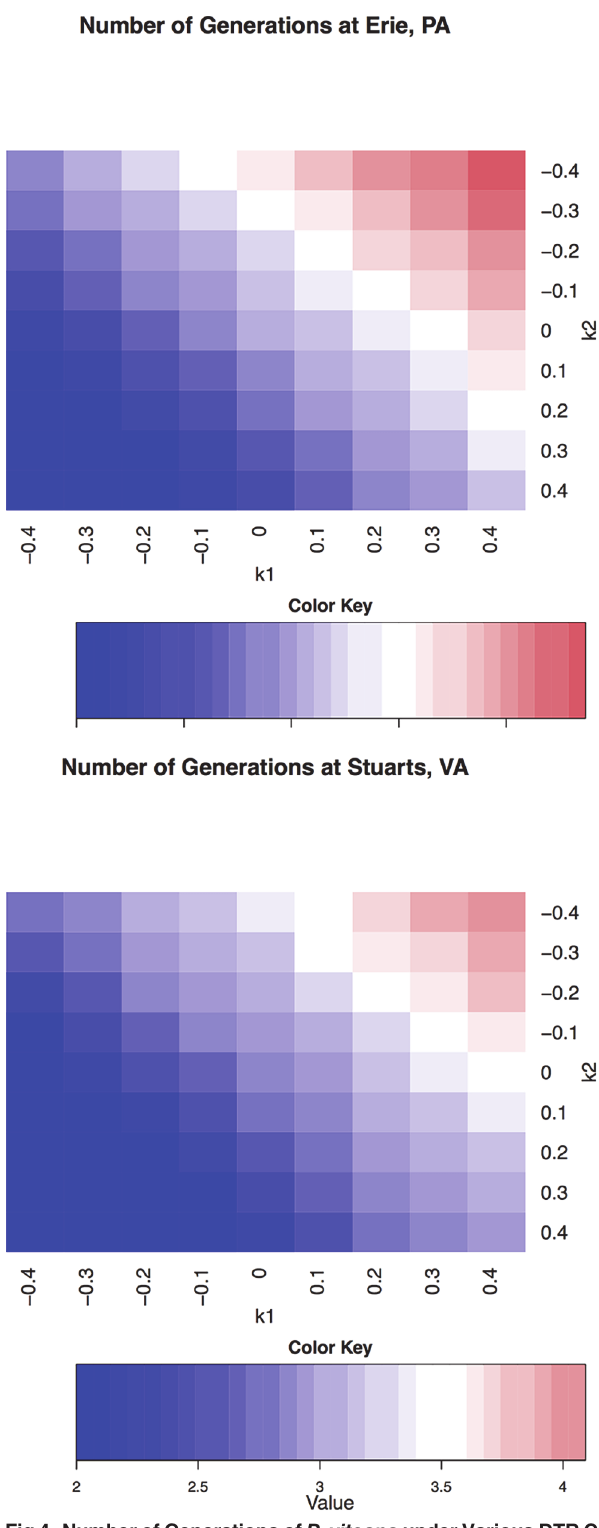
Fig 4. Number of Generations of P . viteana under Various DTR Change Conditions in Erie, PA and Stuarts Draft, VA. Note: Upper panel for Erie and lower panel for Stuarts Draft. T ’ min = Tmin+k 1 * Tmean